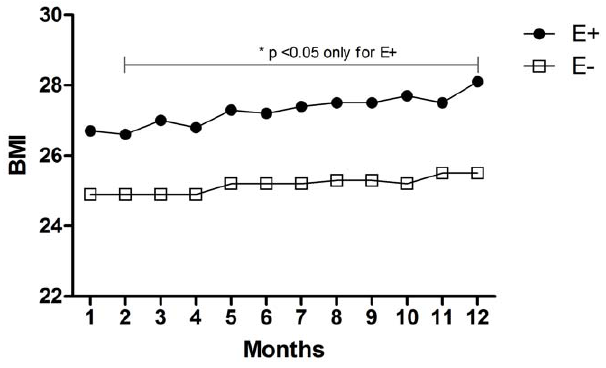
Figure 2. Twelve-month evolution of the body mass index (BMI) in the patient cohort.